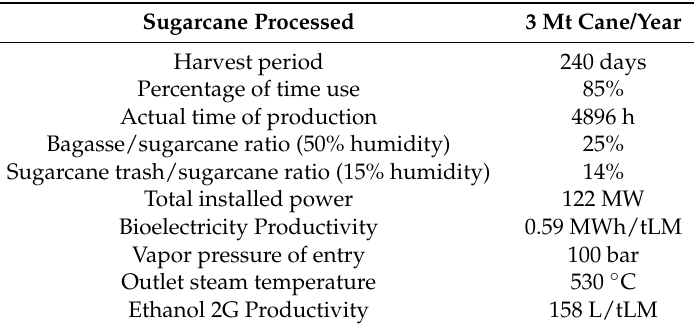
Table 1. Technical data used in this study.